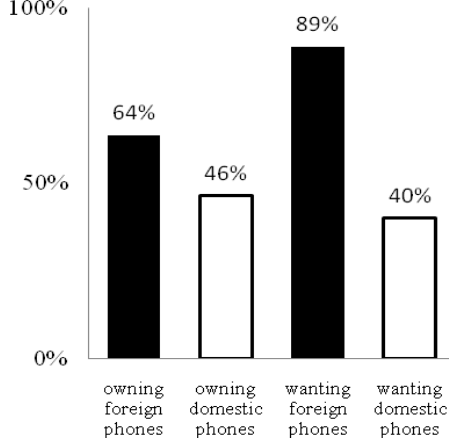
Figure 1: Percentage of ownership and purchase intention of foreign and domestic cell phones